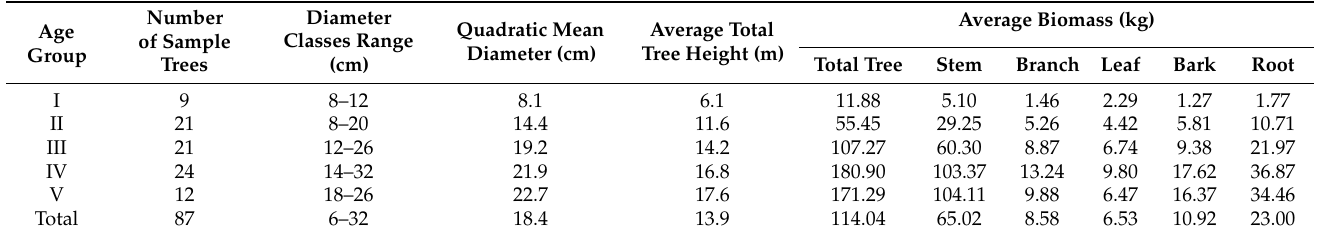
Table 2. Sample tree characteristics of temporary plots of Chinese fir